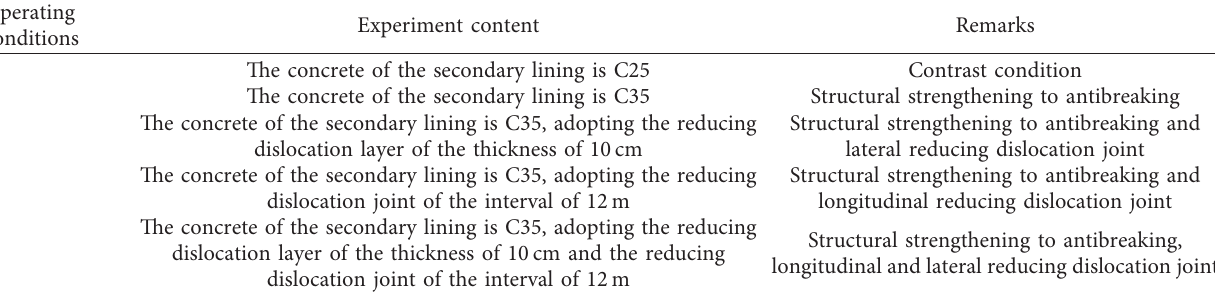
Table 1: Test schemes.